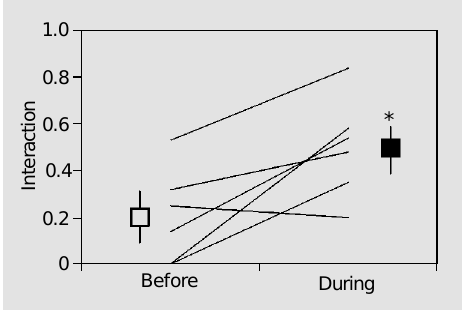
Table 1. Mean scores on the opinion about mental illness (OMI) factors 1 of nursing aides (N = 9) before and during IOSPI